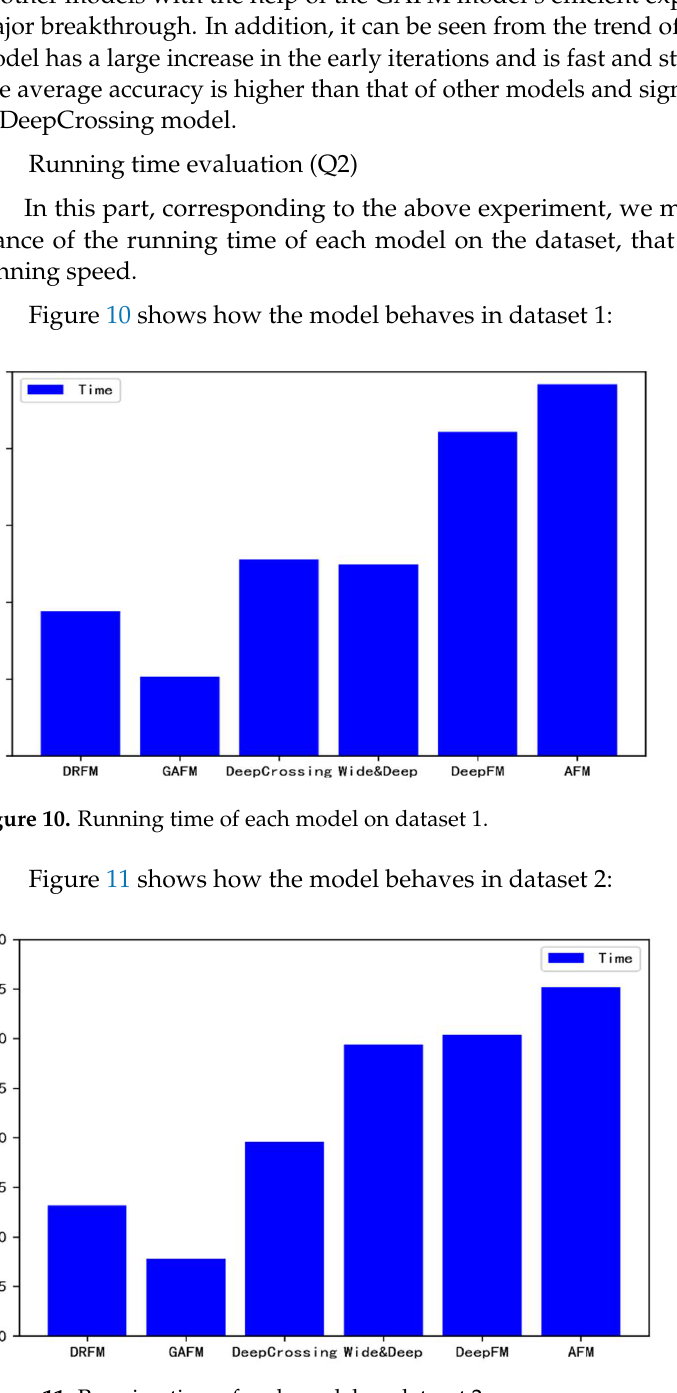
Figure 9. Accuracy of each model in dataset 3.